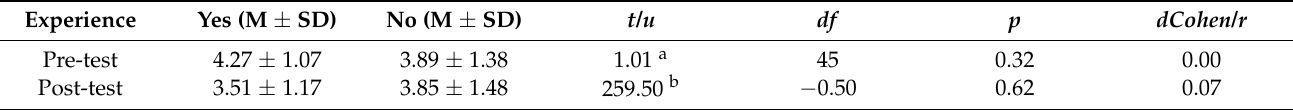
Table 4. Results of the RPE scale in the assessment tests according to prior experience.